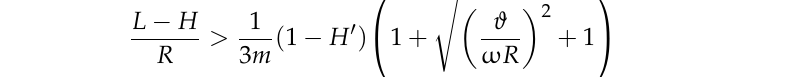
Table 1. High pressure torsion extrusion (HPTE) parameters for analysis of the model used to calculate the graphs presented in Figure 2.